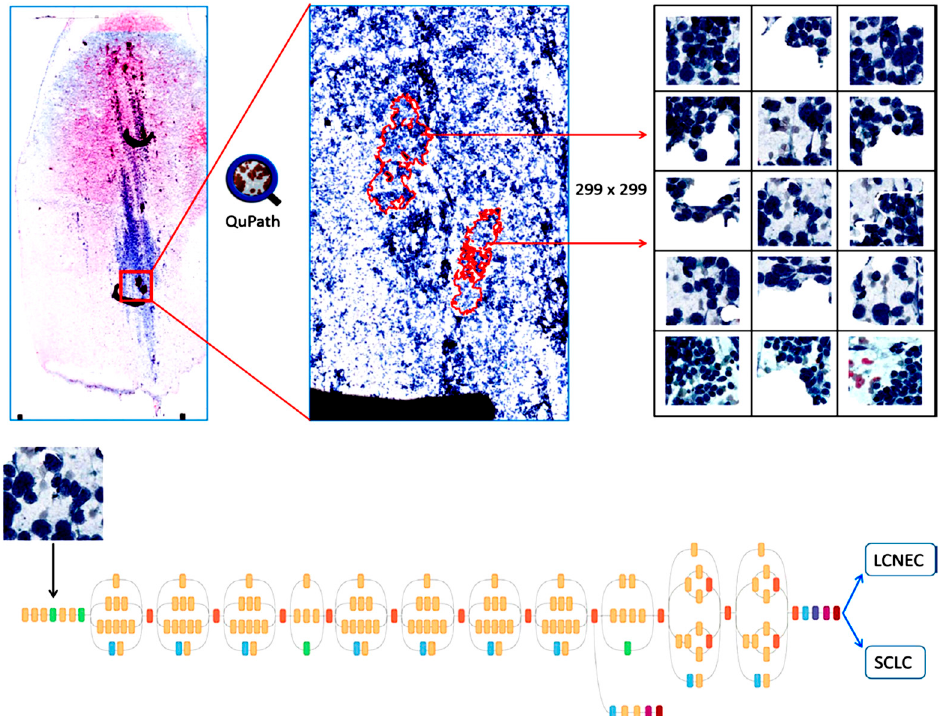
Figure 10. Example of cytological classification of lung cancer. ( Top panel) Diagram showing the workflow for annotating and exporting image tiles using QuPath for subsequent input into the convolutional neural network. ( Bottom panel) Schematic of the convolutional neural network architecture based on Google Inception V3 (adapted from https://github.com/tensorflow/models/tree/masterr/research/inception). (Source: Figure 2 in Gonzalez et al. Reprinted with permission from the authors. Copyright (2019), Cytopathology published by Wiley [28] .)